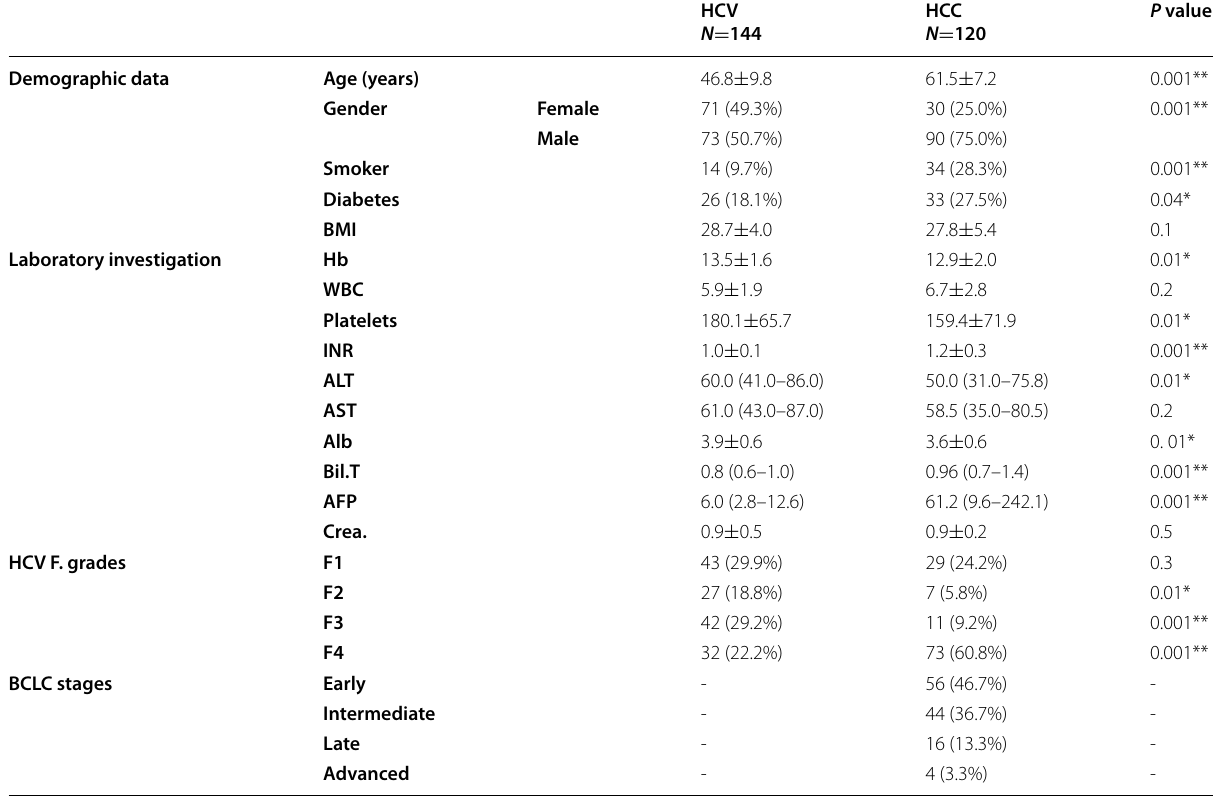
Table 1 Demographic and clinical characteristics of HCV and HCC patients